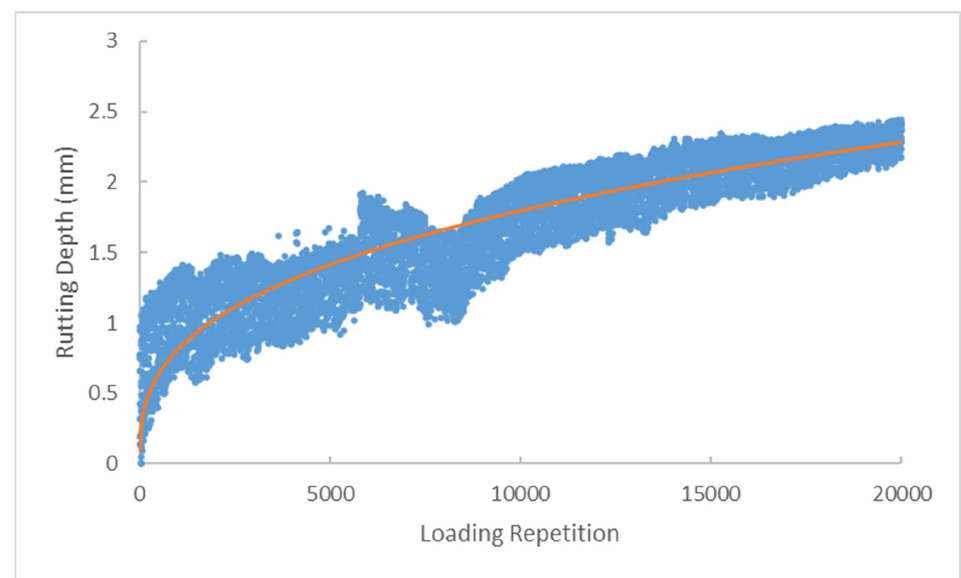
Figure 11. 2# HWT test results and fitted power model.